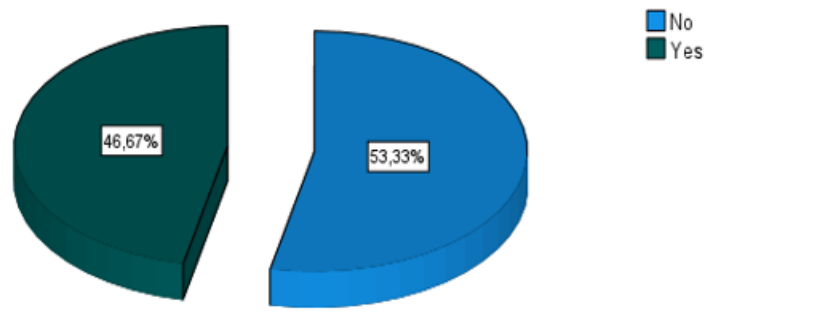
Figure 4. Pie chart presenting the percentages of teachers’ willingness to working with immigrant